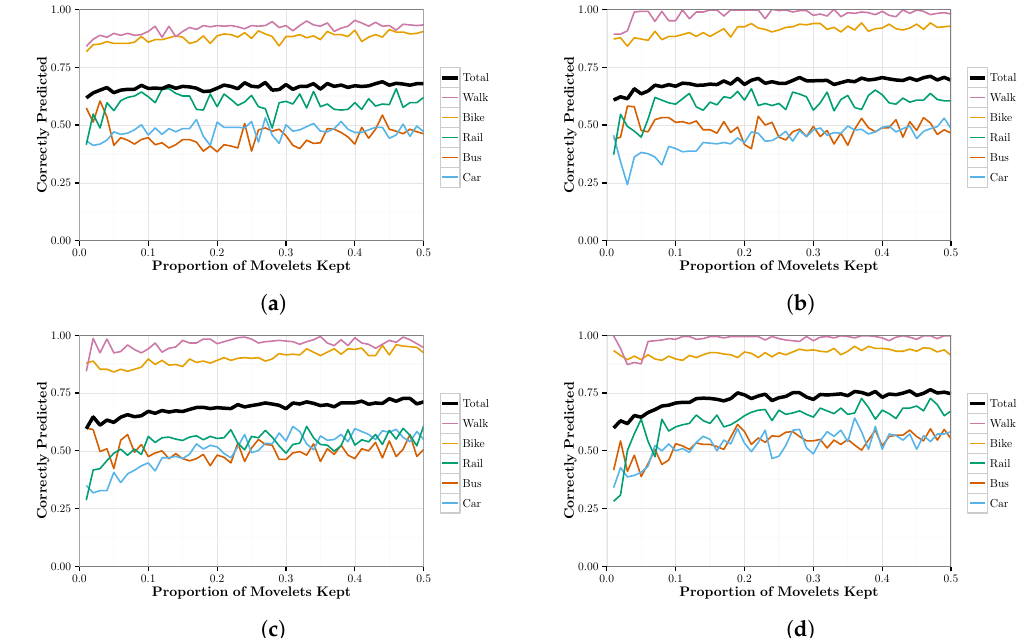
Figure 1. Graphs representing the proportion of correctly predicted movelets by mode of transportation as the proportion of movelets kept in a chapter is increased for movelets of a specified time length.